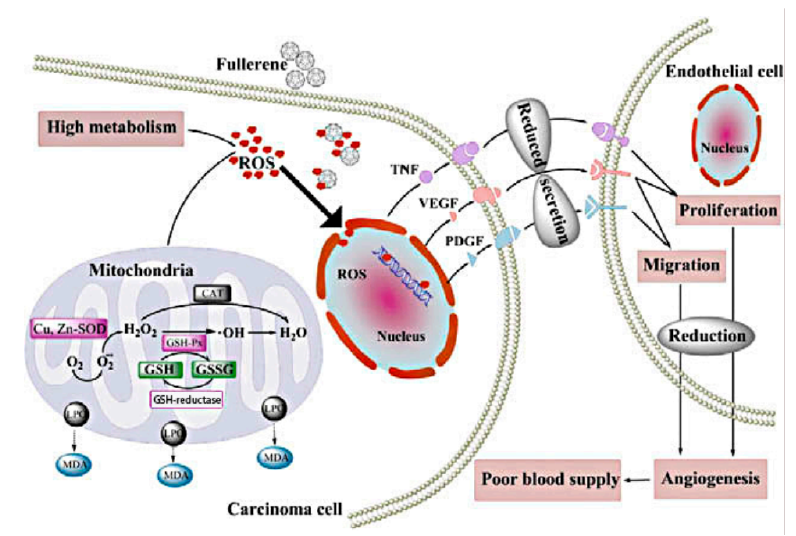
Figure 3. Possible anti-metastatic mechanism of C 60 (OH) 20 nanoparticles in vivo [4].